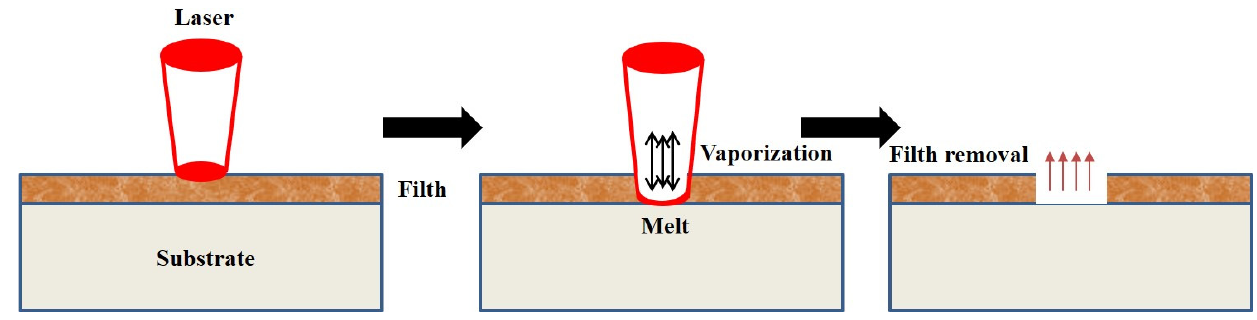
Figure 1. Laser ablation mechanism.